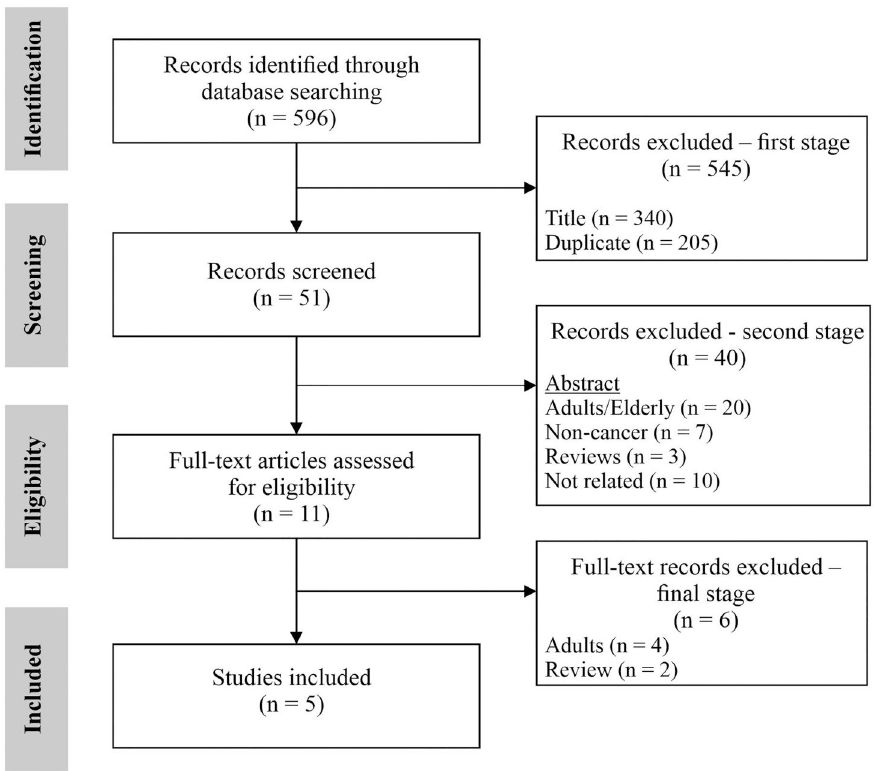
Figure 1 - Flow diagram of study selection.